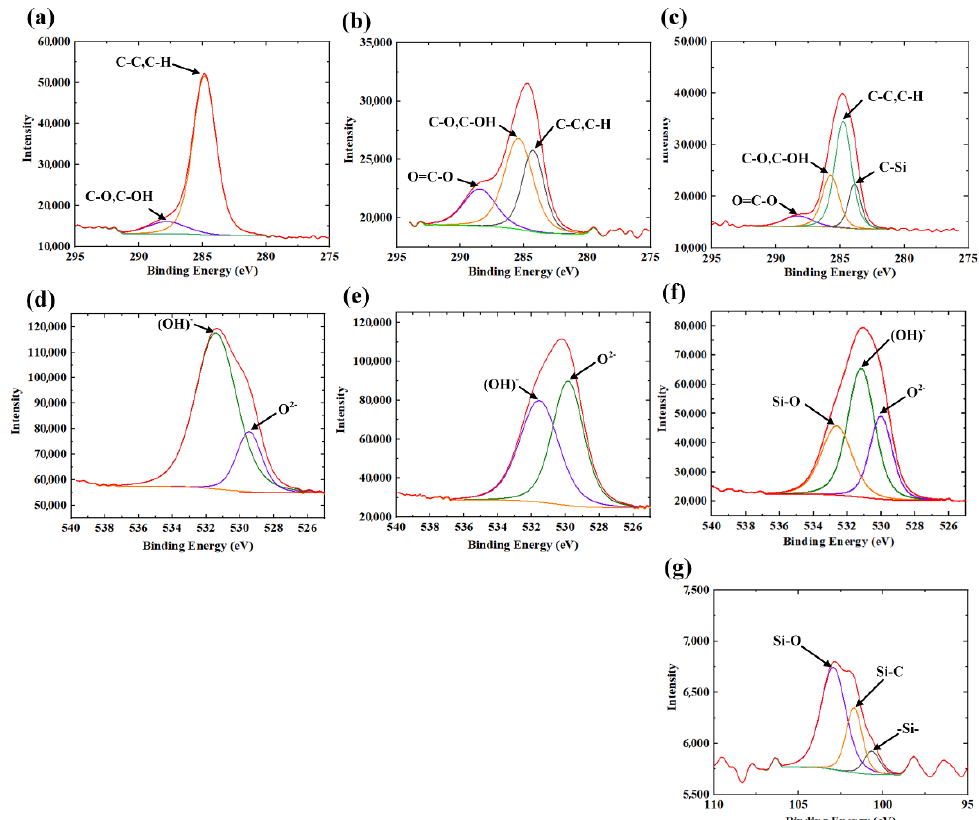
Figure 10. The high-resolution core elemental spectra of carbon on ( a ) untreated BMG surface; ( b ) laser textured BMG surface; ( c ) laser textured BMG surface followed by heat treatment. The high-resolution core elemental spectra of oxygen on ( d ) untreated BMG surface; ( e ) laser textured BMG surface; ( f ) laser textured BMG surface followed by heat treatment; and ( g ) the high-resolution core elemental spectra of silicon on the laser textured BMG surface followed by heat treatment.